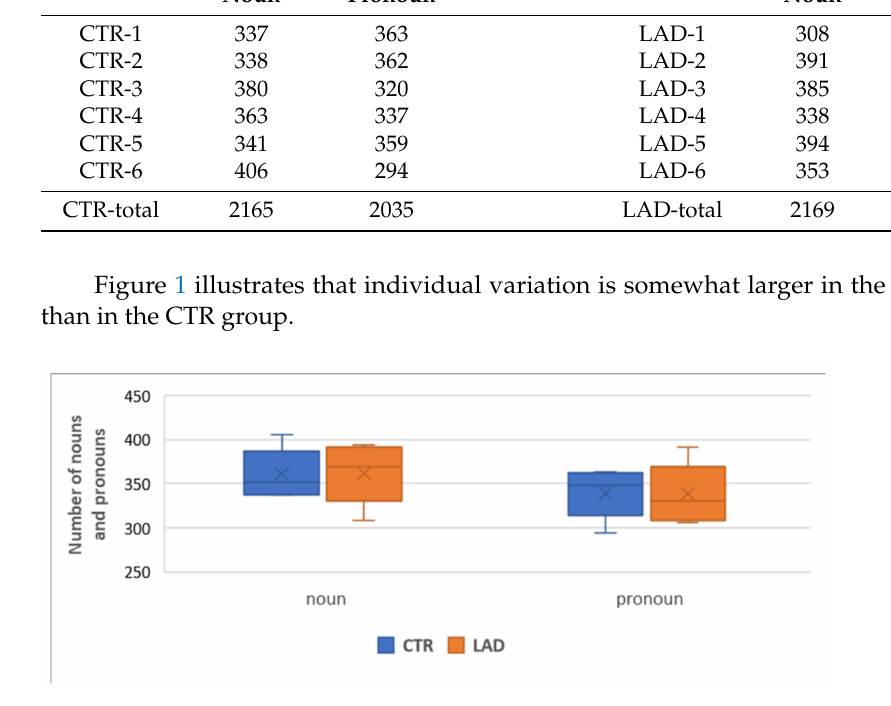
Figure 1. Range of proportions of nouns and pronouns in the CTR group and the LAD